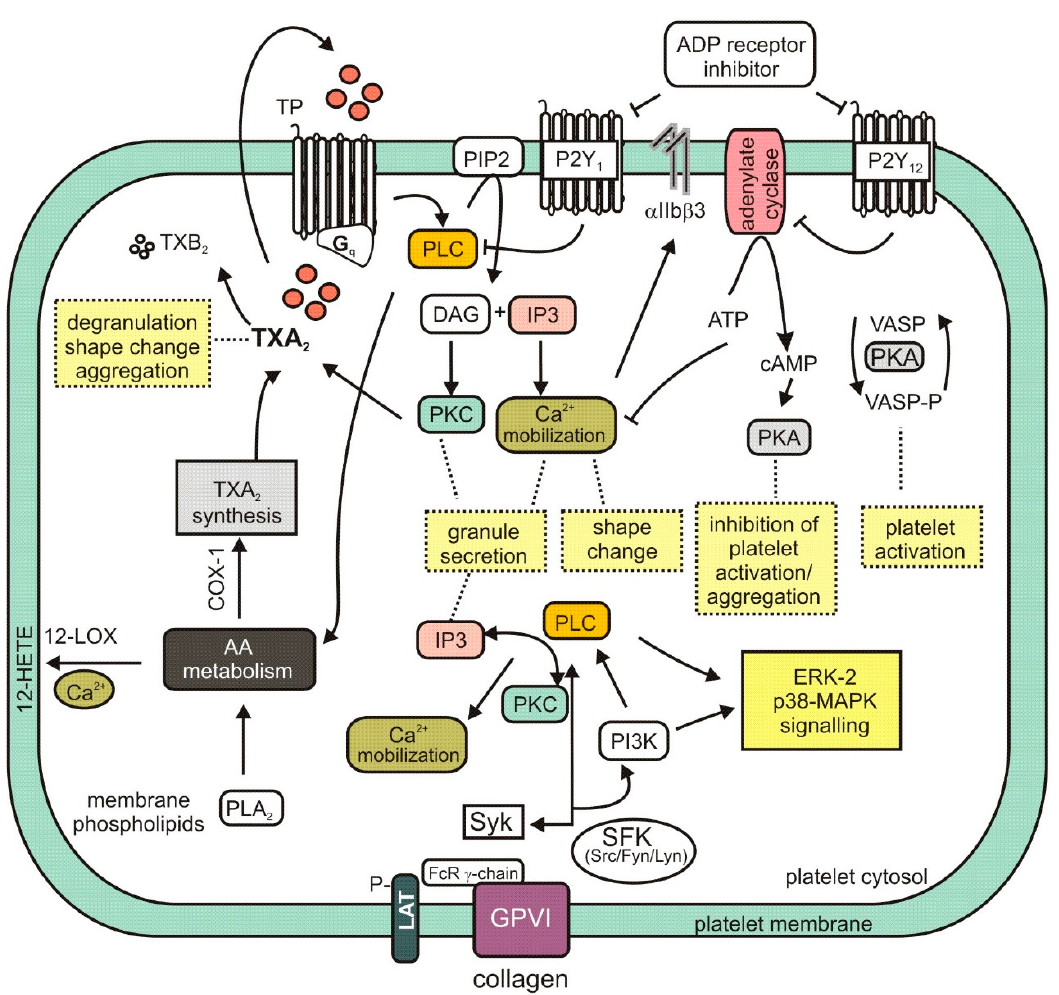
Figure 2. Mechanism of platelet activity modulation showing selected intracellular signaling pathways. 12-HETE, 12-hydroxy-5,8,10,14-eicosatetraenoic acid; 12-LOX, arachidonate 12-lipoxygenase; AA, arachidonic acid; ADP, adenosine 5 ′ -diphosphate; cAMP, adenosine 3 ′ , 5 ′ -cyclic monophosphate; COX-1, cyclooxygenase-1; DAG, 1,2-diacylglycerol; GPVI, glycoprotein VI; IP3, inositol-1,4,5-trisphosphate; LAT, linker for activation of T cells; MAPK, mitogen-activated protein kinase; P2Y 1 , ADP receptor; P2Y 12 , ADP receptor; PI3K, phosphoinositide 3-kinase; PIP2, phosphatidylinositol biphosphate; PKA, protein kinase A; PKC, protein kinase C; PLA2, phospholipase A2; PLC, phospholipase C; SFK, Src-family kinase; Syk, spleen tyrosine kinase; TP, thromboxane receptor; TXA 2 , thromboxane A 2 ; TXB 2 , tromboxane B 2 ; VASP, vasodilator-stimulated phosphoprotein.